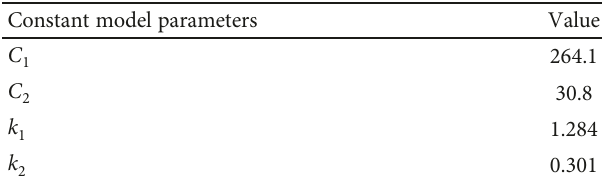
in . Table 3: Constant thermal model